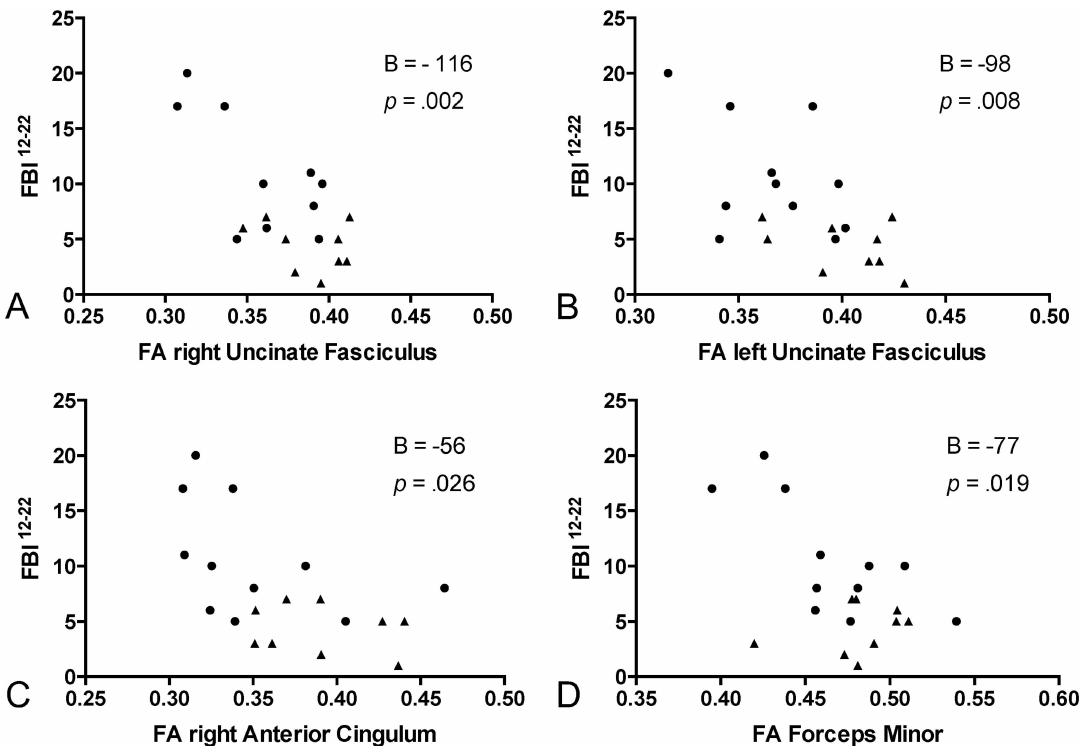
Fig 4. Frontal Behavioural Inventory and FA of tracts. Scatter plots of Frontal BehaviouralInventory composite score of items 12–22 (FBI 12-22 ) and fractional anisotropy(FA) of tracts in patients with behaviouralvariant frontotemporal dementia (bvFTD) (dots) and progressive supranuclear palsy (PSP) (triangles), for A: the right uncinate fasciculus, B: the left uncinate fasciculus, C: the anterior cingulumand D: the forceps minor. B (adjusted) and p are derived from the linear regression model, with age as